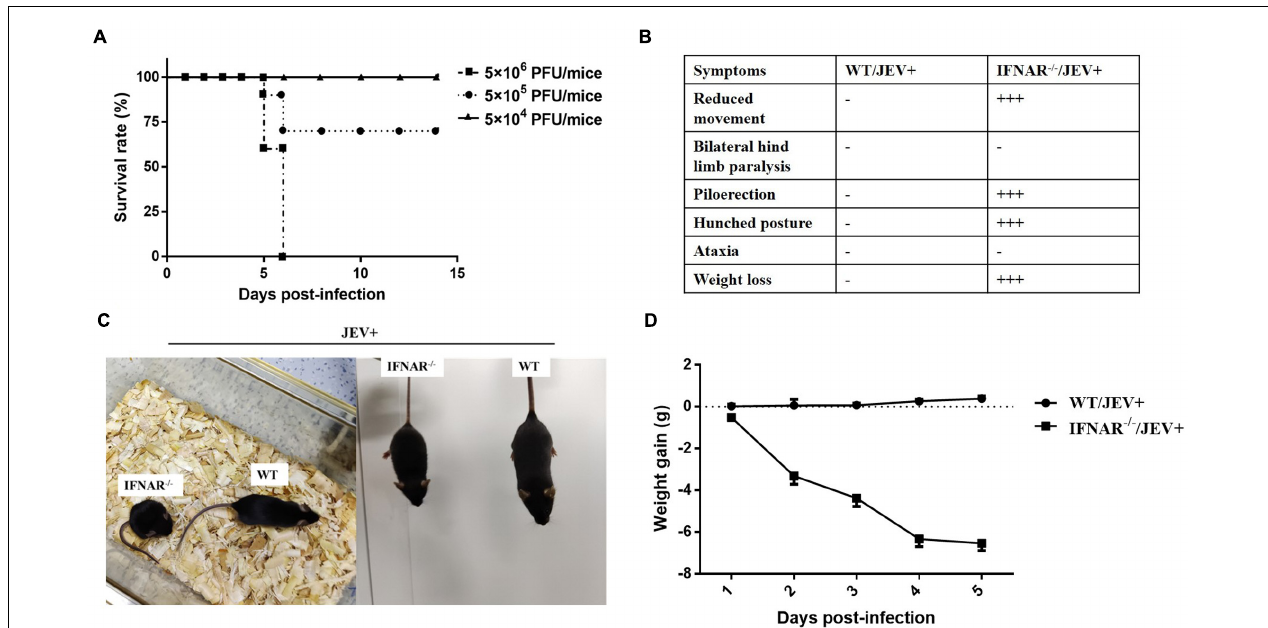
FIGURE 1 | Mice lacking IFNAR were susceptible to JEV vaccine strain SA14-14-2. (A) Survival curves for IFNAR − / − mice ( n = 10) intraperitoneally infected with 10-fold dilutions of JEV vaccine strain SA14-14-2 (5 × 10 6 PFU/mice, 5 × 10 5 PFU/mice, and 5 × 10 4 PFU/mice). Mice were monitored daily for up to 14 days. (B) The clinical presentation and (C) representative images of wild-type (WT) and IFNAR − / − mice intraperitoneally infected with SA14-14-2 (5 × 10 6 PFU/mice) at 4 days post-infection (dpi). − : no significant clinical change. +++: very significant clinical change. (D) Weight gain of JEV SA14-14-2 (5 × 10 6 PFU/mice) infected wild-type (WT) and IFNAR − / − mice ( n = 6 per